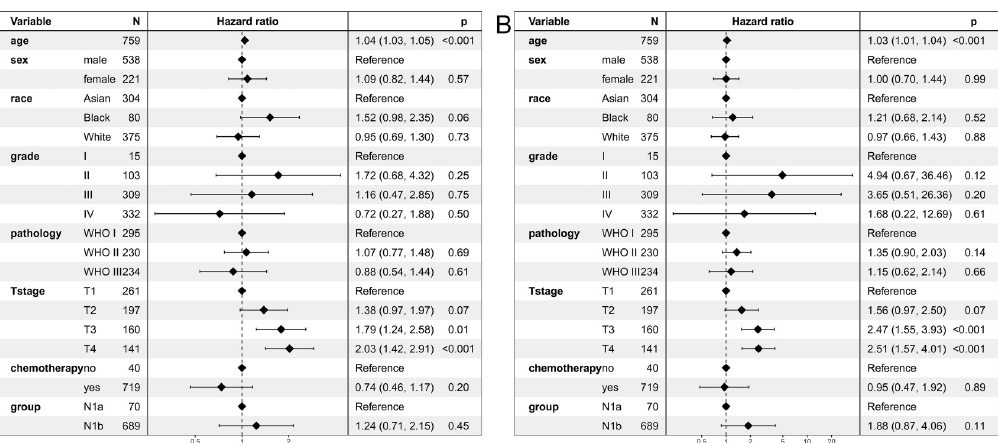
PLOS ONE | https://doi.org/10.1371/journal.pone.0253424 June 17,